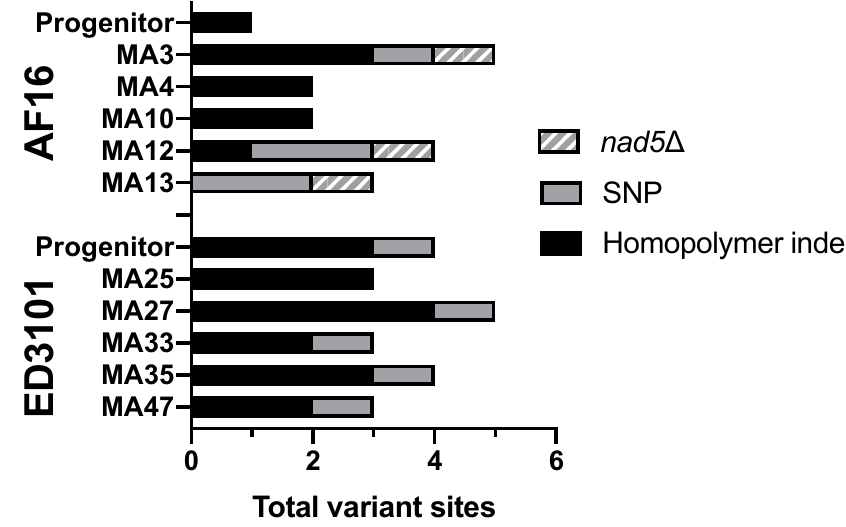
Figure 3. Total number of variant sites for each AF16 and ED3101 MA line and progenitor. The lined bars designate MA lines that also harbored an 870 bp deletion occurring between ψ nad5-2 and nduo-5 .